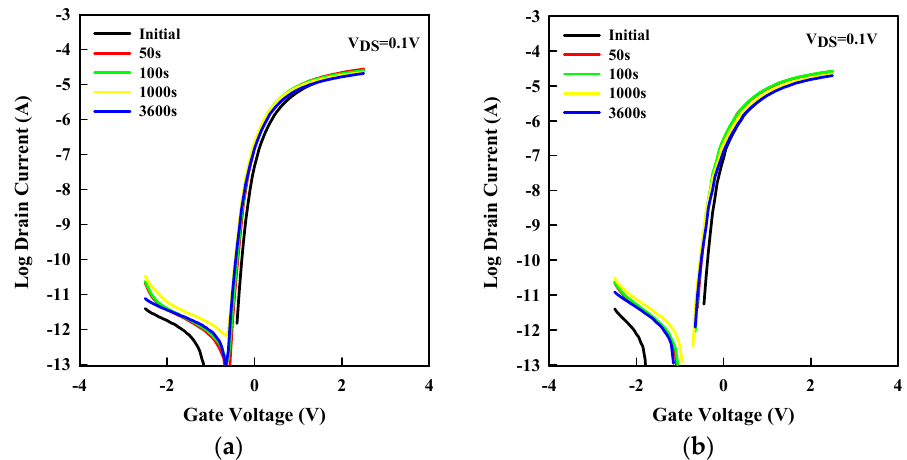
Figure 5. a-SnOx TFTs under various stress during 3600 s. The evolution of the transfer curve of a-SnO x TFT under ( a ) positive gate bias stress and ( b ) negative bias stress. After 50, 100, 1000, and 3600 s, a transfer curve was measured (at V DS = 0.1 V). One color is shown per